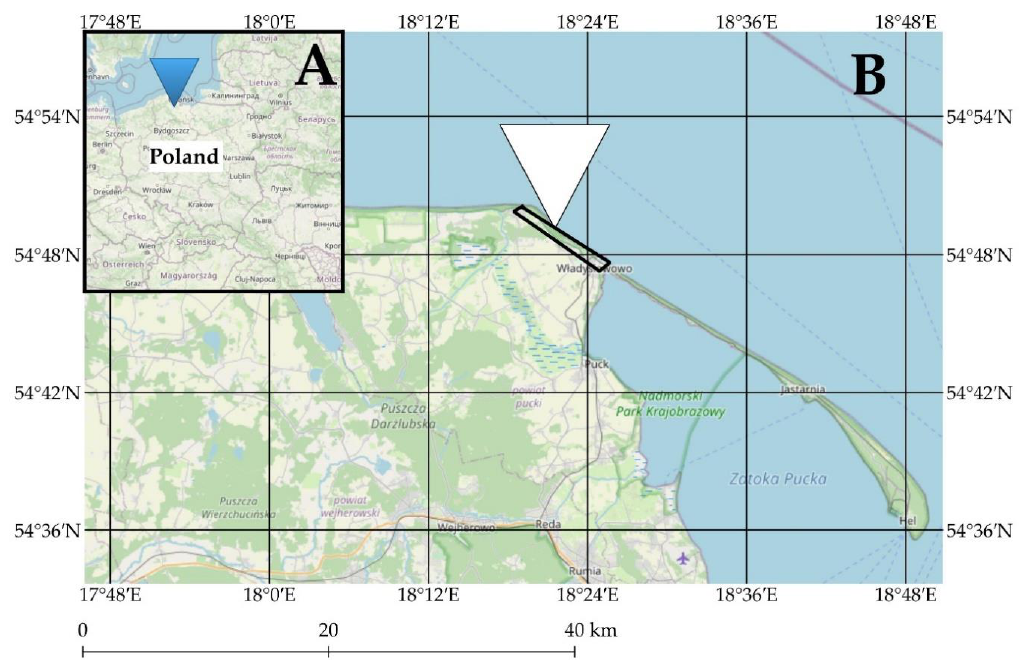
Figure 1. ( A ) location of the sampling area within the southern Baltic Sea; ( B ) exact measurement locations outlined in black (source: OpenStreetMap).